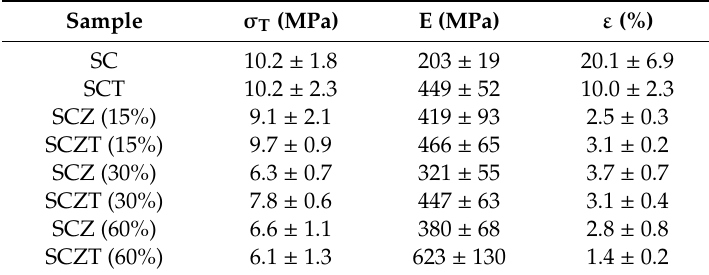
Table 1. Tensile strength ( σ T ), Young’s moduli of elasticity and deformation at fracture (E) and elongation to break ( ε ) of the control and thymol impregnated SC and SCZ films.